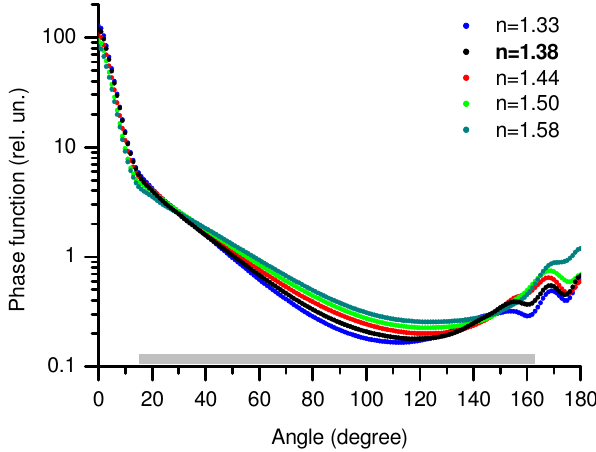
Figure 6. Refractive index dependence of phase functions. The range of the Polar Nephelometer operating angles is indicated by the gray